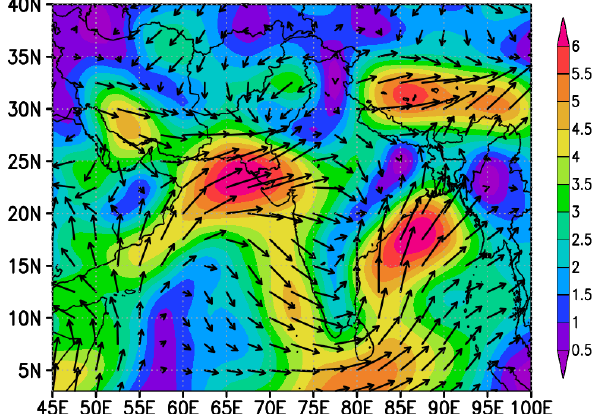
Figure 3. Long-term mean (1968–1996) 1000mb wind vectors for April from NCEP/NCAR reanalysis. Shading represents wind speed in ms − 1